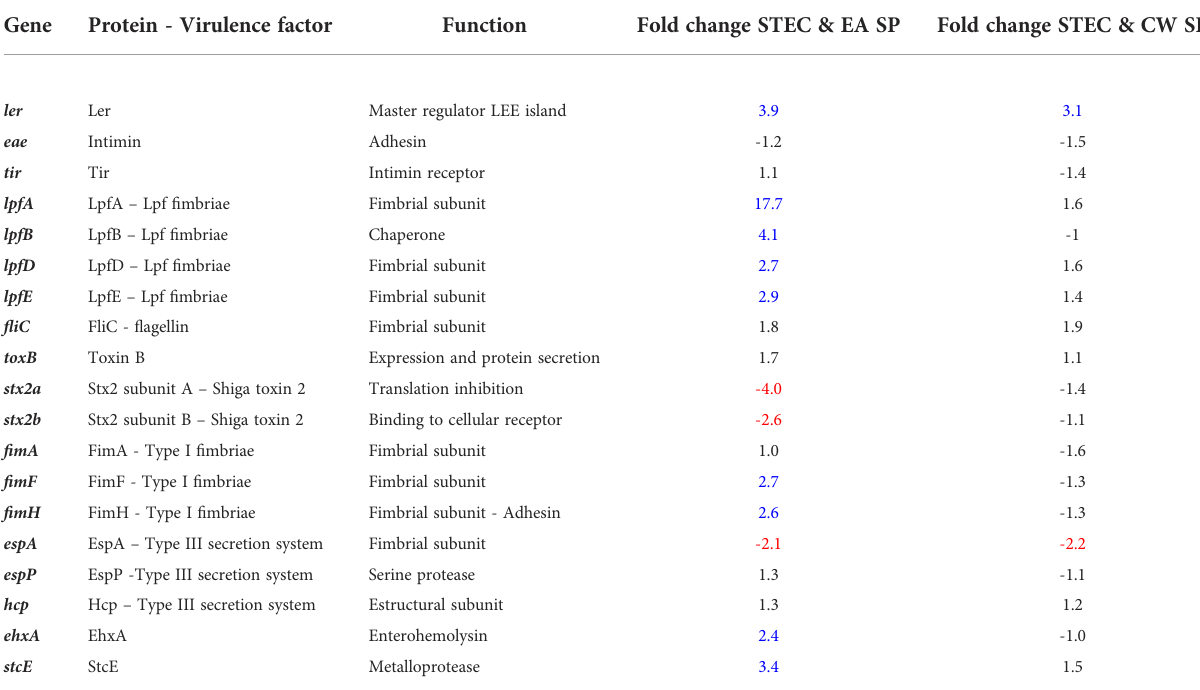
TABLE 1 Changes in gene expression for the main virulence factors in STEC.